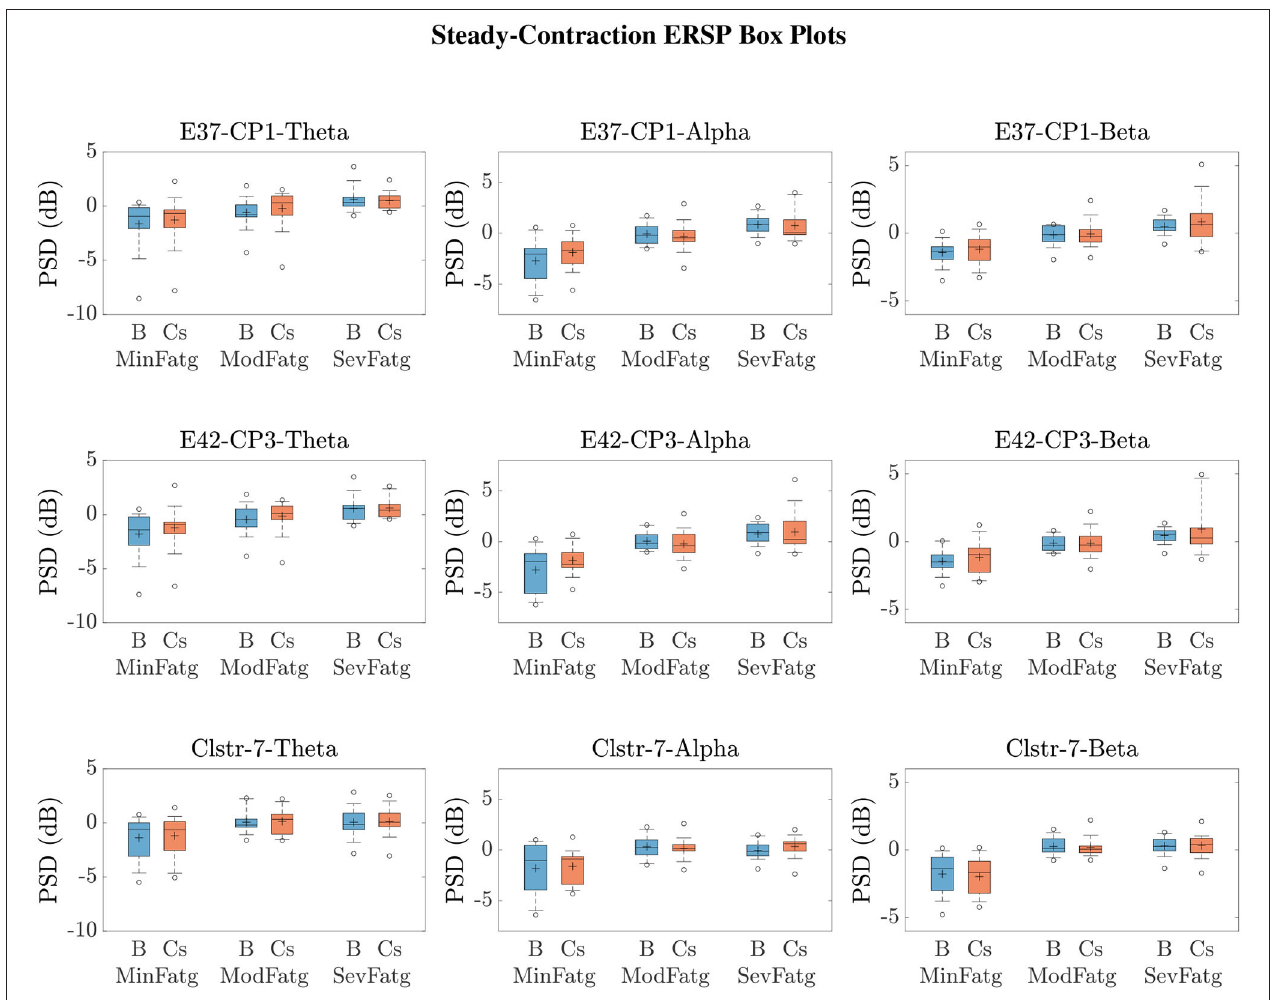
FIGURE 10 | To study the modulation of band-specific ERSP values across the fatigue conditions, the time-averaged PSD values for the steady contraction and baseline were averaged over the EEG frequency bands of interest. The box plots of ≈ B (row 1) and CP3 (row 2) affirm that the theta-, alpha-, and beta-band PSD scale with the fatigue level during the baseline (B) and steady-contraction (Cs) interval. Likewise, the theta-, alpha-, and beta-band PSD computed for IC Cluster 7 proportionally vary with fatigue during B and Cs period (row